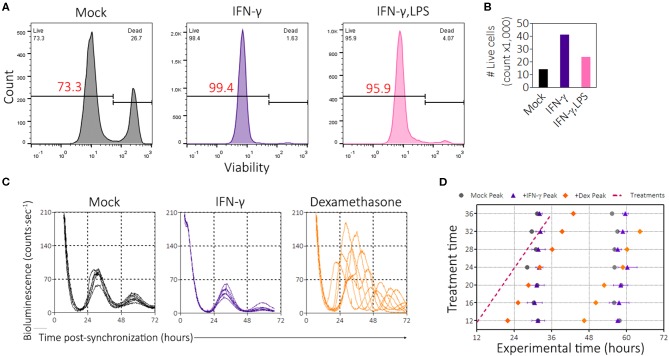
IFN-γ promotes cell survival and proliferation and is not a clock-resetter. (A) Histograms of BMDMs stained with viability dye (zombie red, BioLegend). Gating strategy in Supplemental Figure 3A. (B) Enumeration of the number of events per group in gated flow plots in (A) to determine proliferation. (C) Single, averaged, raw bioluminescence traces of BMDMs treated with IFN-γ (50 ng/mL) or dexamethasone (1 μM) between the times of 12 and 36 h, each sample at every 4 h interval. (D) Circadian wedge diagram depicting time of treatment (magenta dotted line) and time of resultant peaks from each sample group: mock (black circle), IFN-γ (purple triangle), or Dex (orange diamond). Data are represented as mean ± SE (n = 2–3).